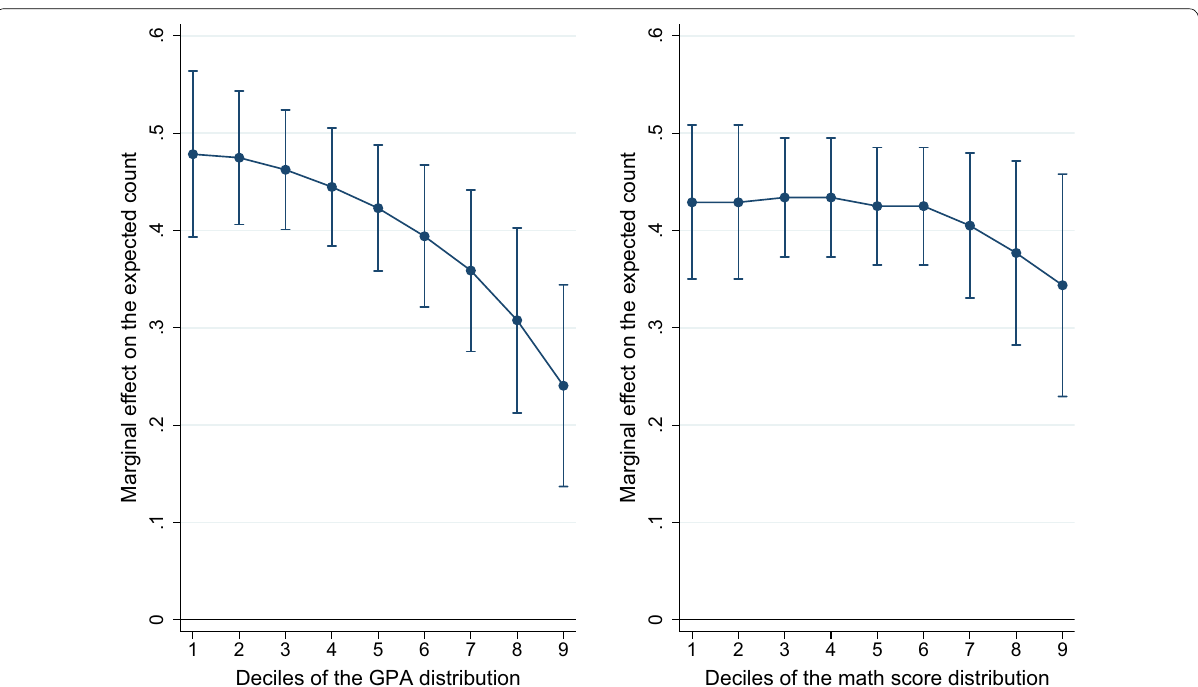
Fig. 2 Conditional low track marginal effects at different performance levels. Confidence intervals are set at the 95% level. High track is the refer- ence